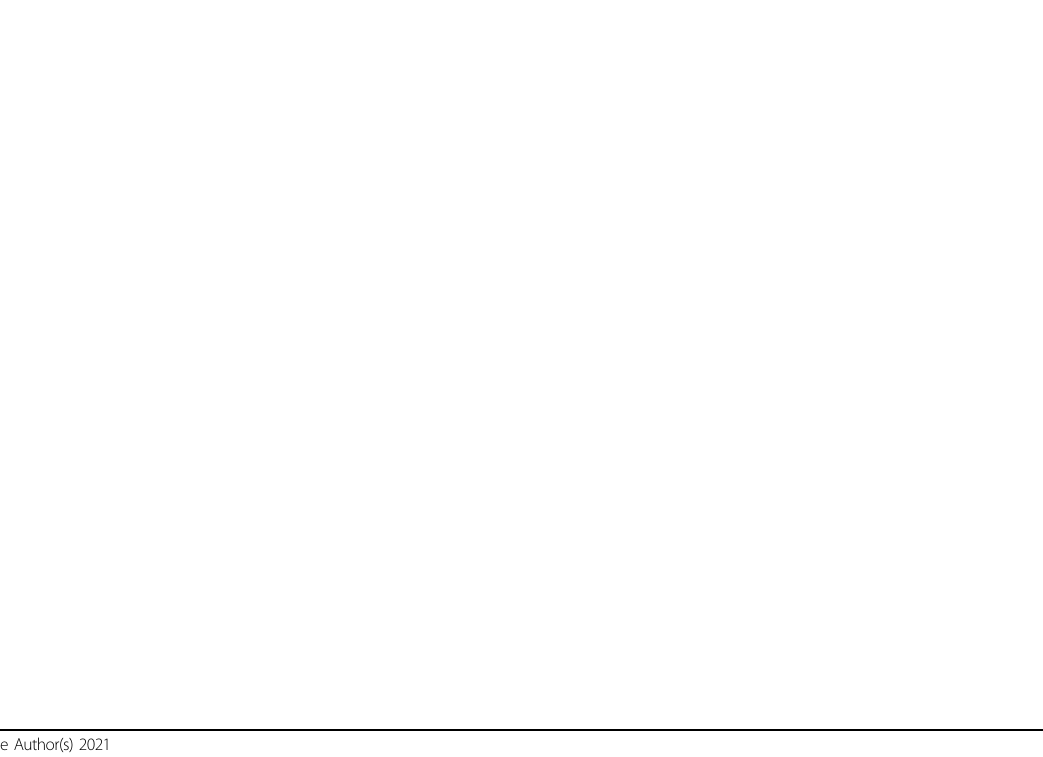
group and stimulus. Mean amplitude (A) and peak latency (B) of the Nc by stimulus and ASD liability groups, averaged across the frontal regions. All error bars repre- sent ±1 standard error. Figure 4 should read: Relationship between Nc features and later dimensional variation in social adaptive skills. Mean amplitude (A) and peak latency (B) difference between face with direct gaze and Noise at 8 months, on the x-axis. Translational Psychiatry apologizes for the errors. The original article has been